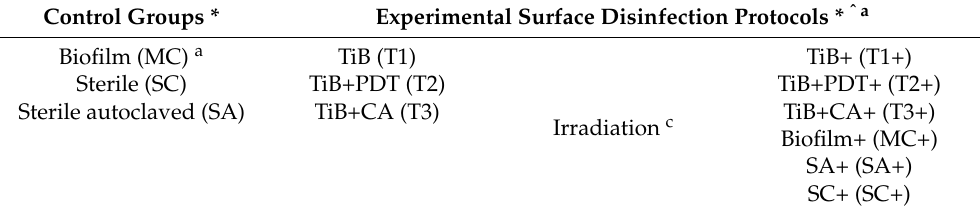
Table 1. Distribution of the experimental and control